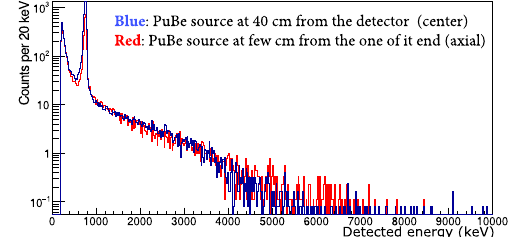
Fig. 3 Left: observed energy spectra with the 3 He counter irradiated by a PuBe neutron calibration source with two different amplification voltages of 1200 V (red) and 1800 V (blue) for which the avalanche